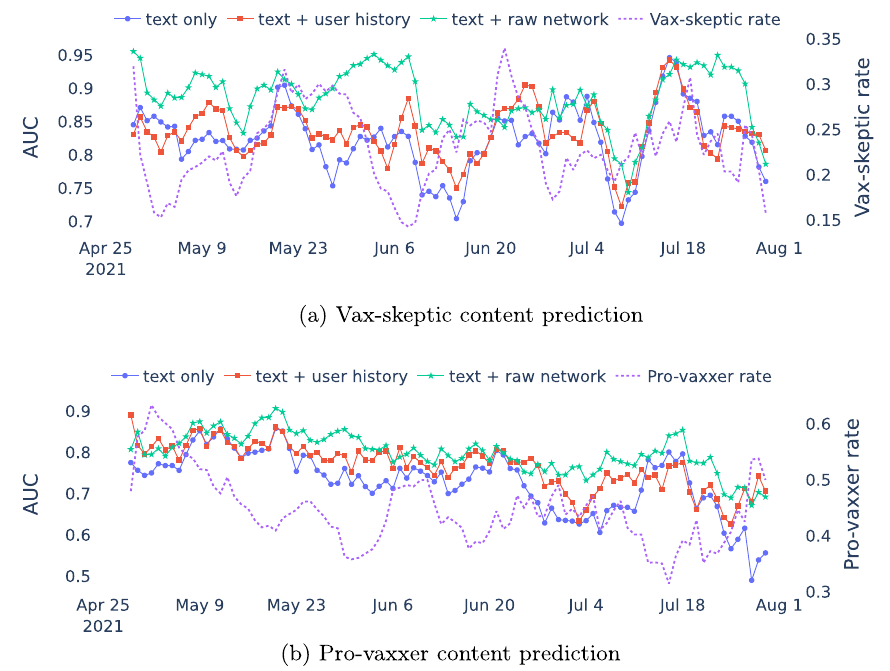
Fig. 13 Model performance (AUC) and vax-skeptic/pro-vaxxer ratio based on a 7-day sliding window in the testing